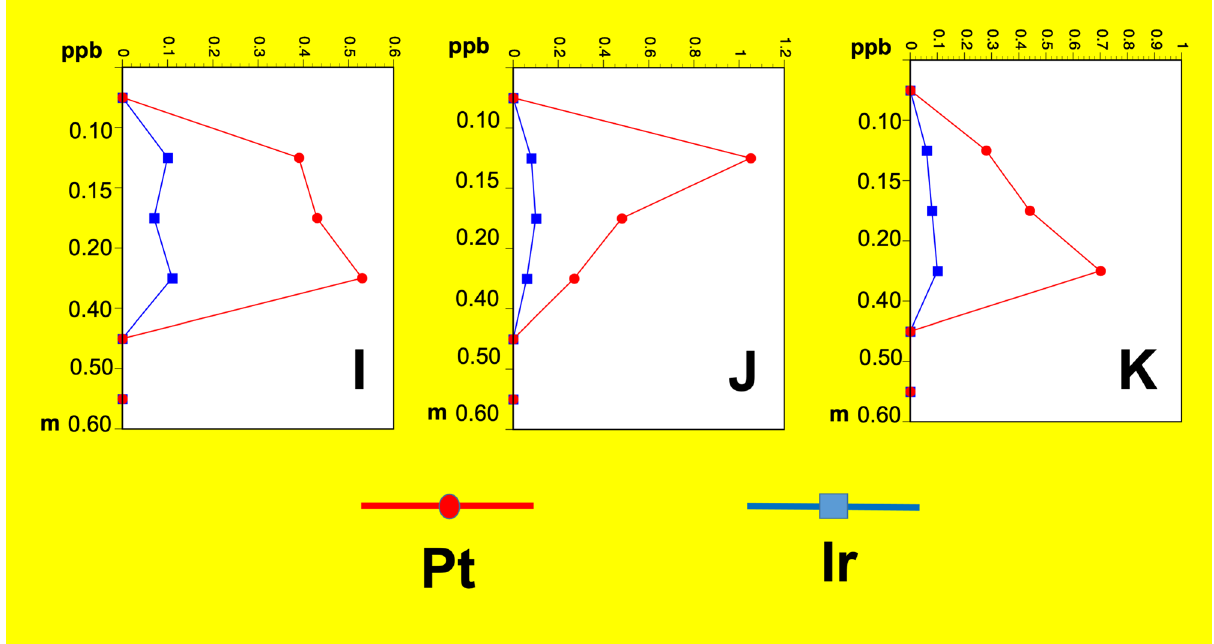
Figure 19. Positive Ir and Pt anomalies from the burned carbon-rich strata on Hopewell archaeological sites in the Ohio River valley: (I) Krasnosky earthworks, Ohio; (J) Junction earthworks, Ohio; (K) Marietta earthworks and mounds, Ohio. Kenneth Barnett Tankersley used Microsoft PowerPoint for Mac Version 16.41 (www. micro soft. com) to create this